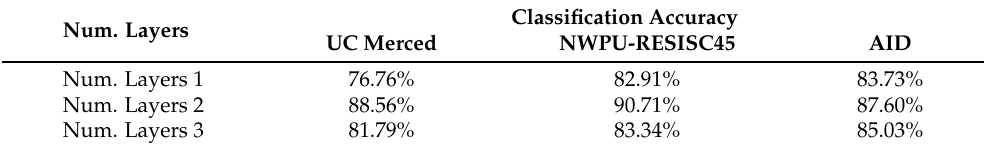
Table 9. Influences of the number of Bayesian edge labeling graph layers on performance. Num.